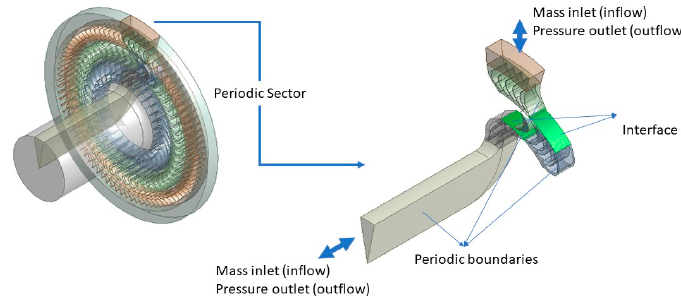
Figure 2. Numerical model domain and boundary